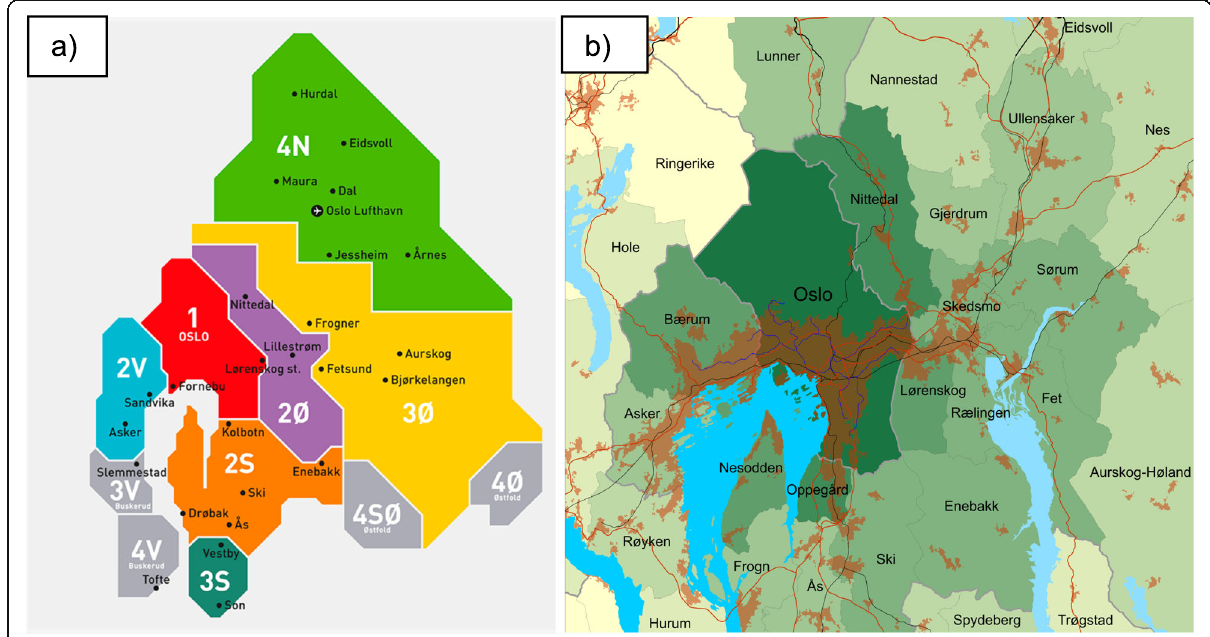
Fig. 7 Map 1. a ) PT zones in Oslo and Akershus municipality (source: Ruter.no); b ) main roads (red), railways (black) and metro lines (purple), overlaid on buildt-up area (brown), and commuting shares (shades of green) (source: Institute of Transport